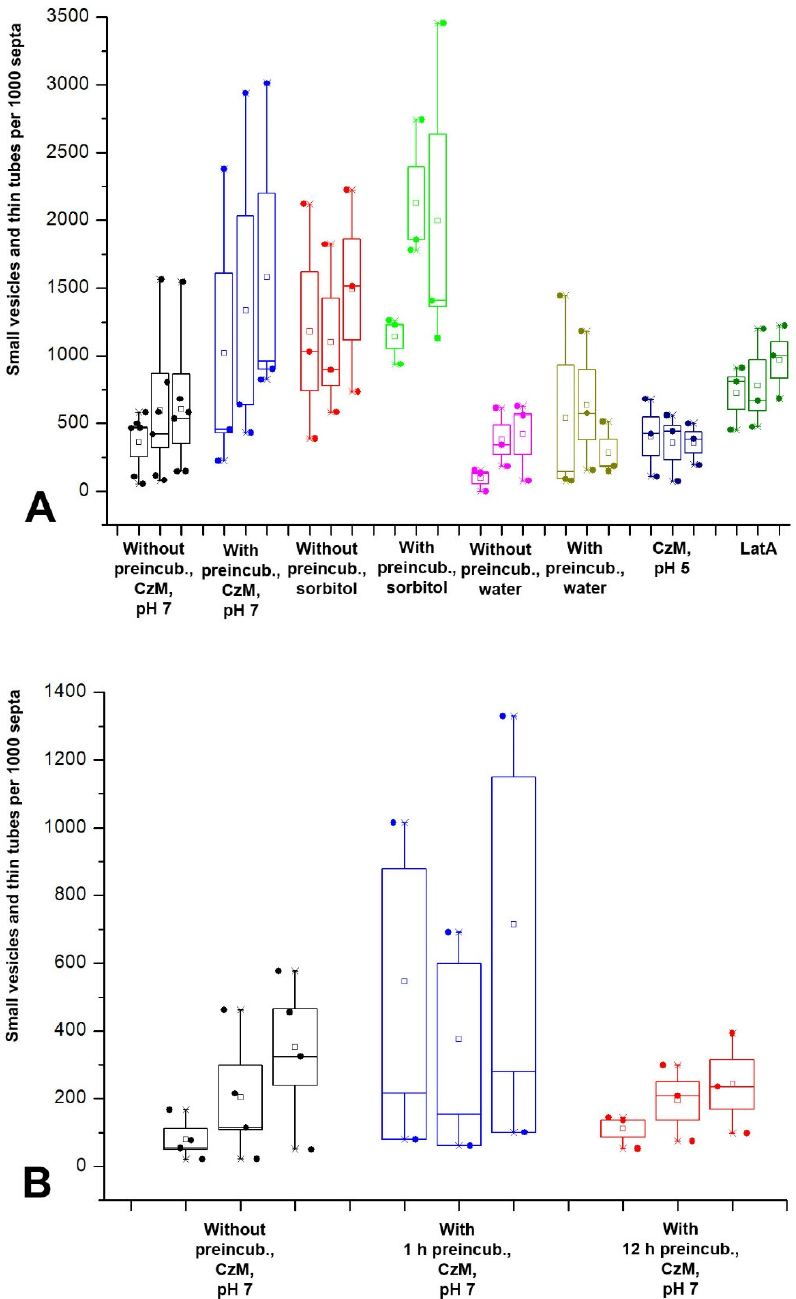
Figure 6. Diagrams showing the quantitative representation of small vesicles and thin tubes in S. hirsutum and O. olearius . ( A )—influence of different variants of microscopic sample preparing on the formation of small vesicles and thin tubes in S. hirsutum . ( B )—influence of the preincubation time on the formation of small vesicles and thin tubes in O. olearius . Legend: small square—mean; box—50% standard deviation, the whisker–min/max.